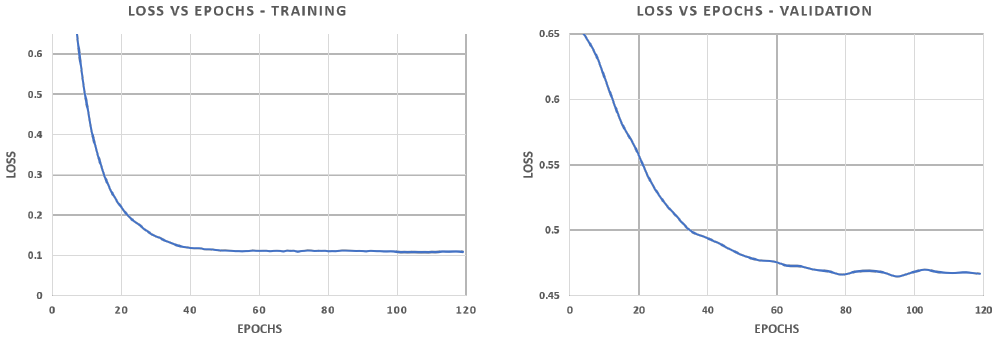
Figure 8. Loss plots for the oversampled (and ecologically partitioned) MIL-1. The curves trend does not highlight overfitting problems.